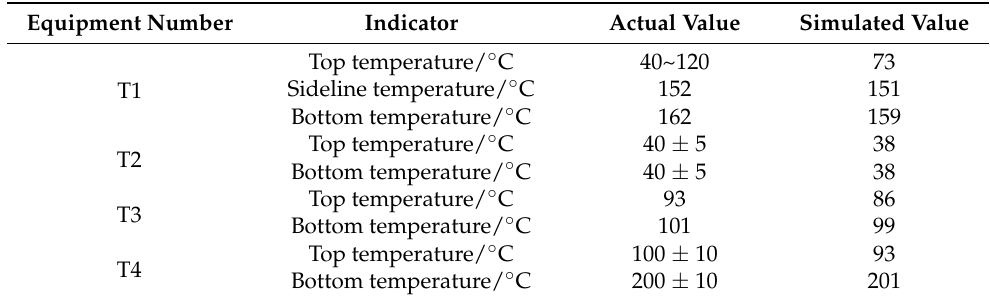
Table 3. Comparison of simulation values and actual parameters.